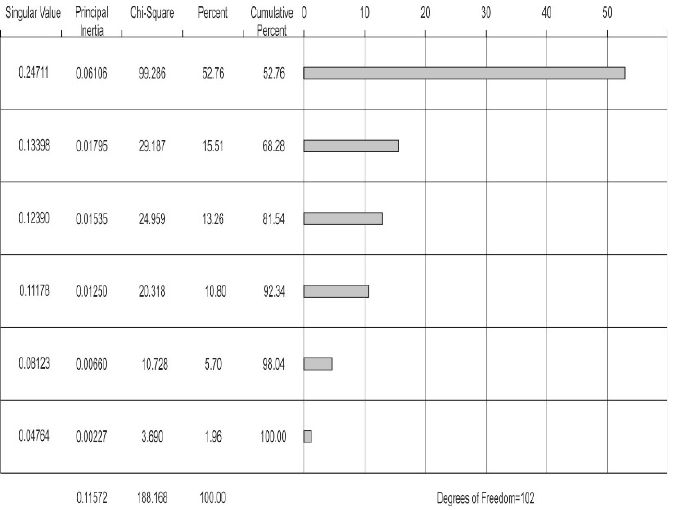
Figure 1. Inertia and chi-square decomposition for injuries in total.